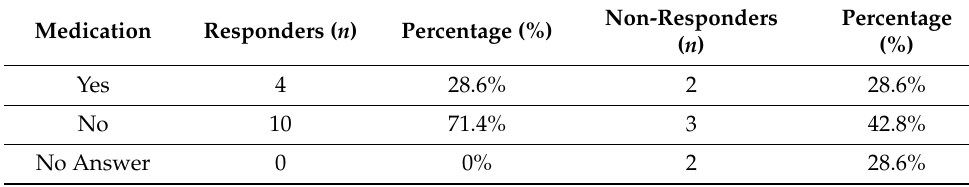
Table 3. Medication of the responders and non-responders at follow-up (FU).